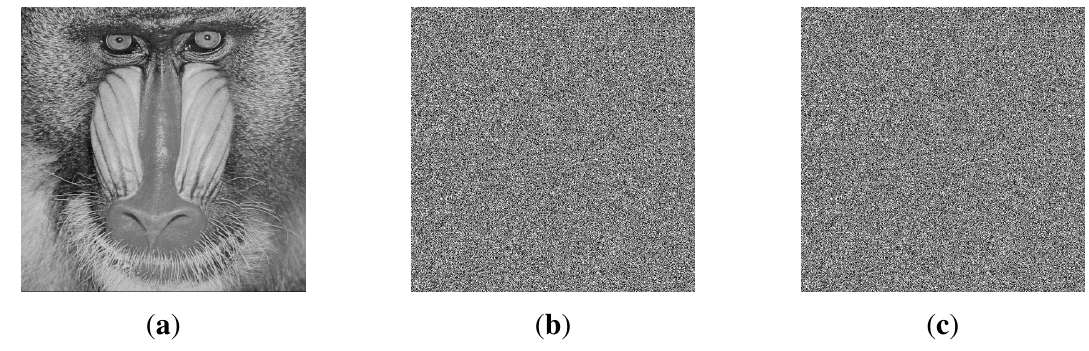
Figure 3. Example: ( a ) original image; ( b ) encrypted image; and ( c ) encrypted image with embedded short